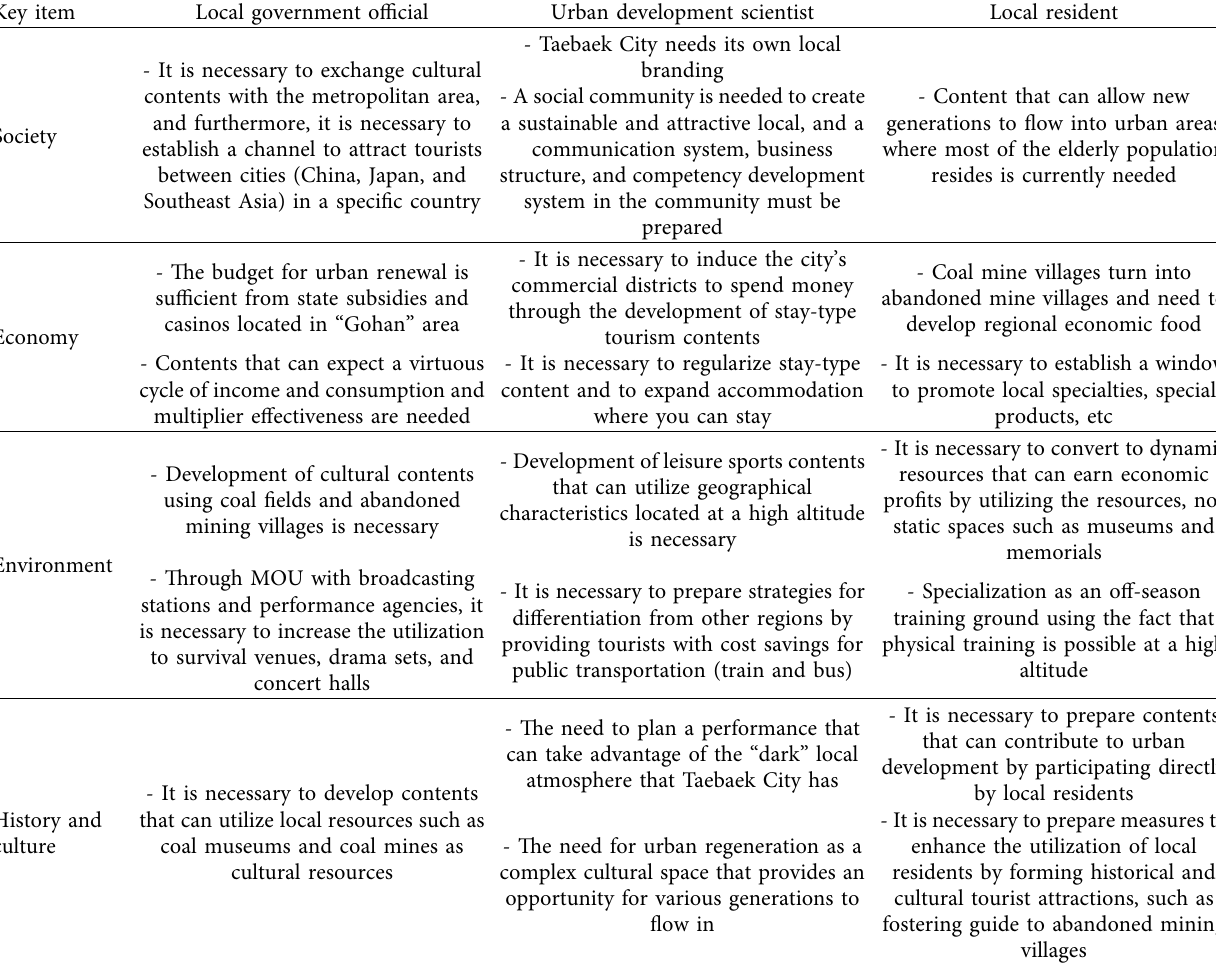
Table 9: Results of in-depth interview with